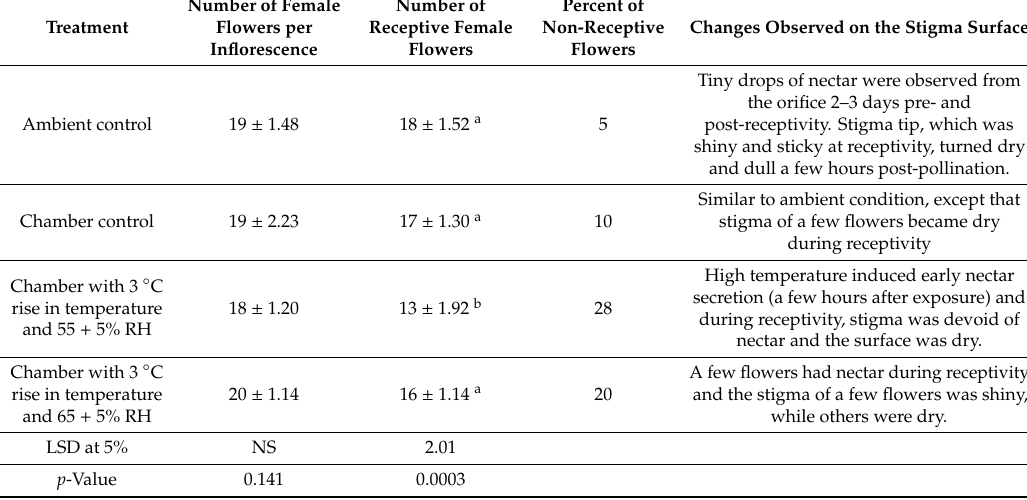
LSD represents least significant di ff erence between treatment means at 5%. Di ff erent letters in each column after the mean values are significantly di ff erent at 5% level according to Duncan’s multiple range test. Significance levels of each factor are indicated by p -values. NS,